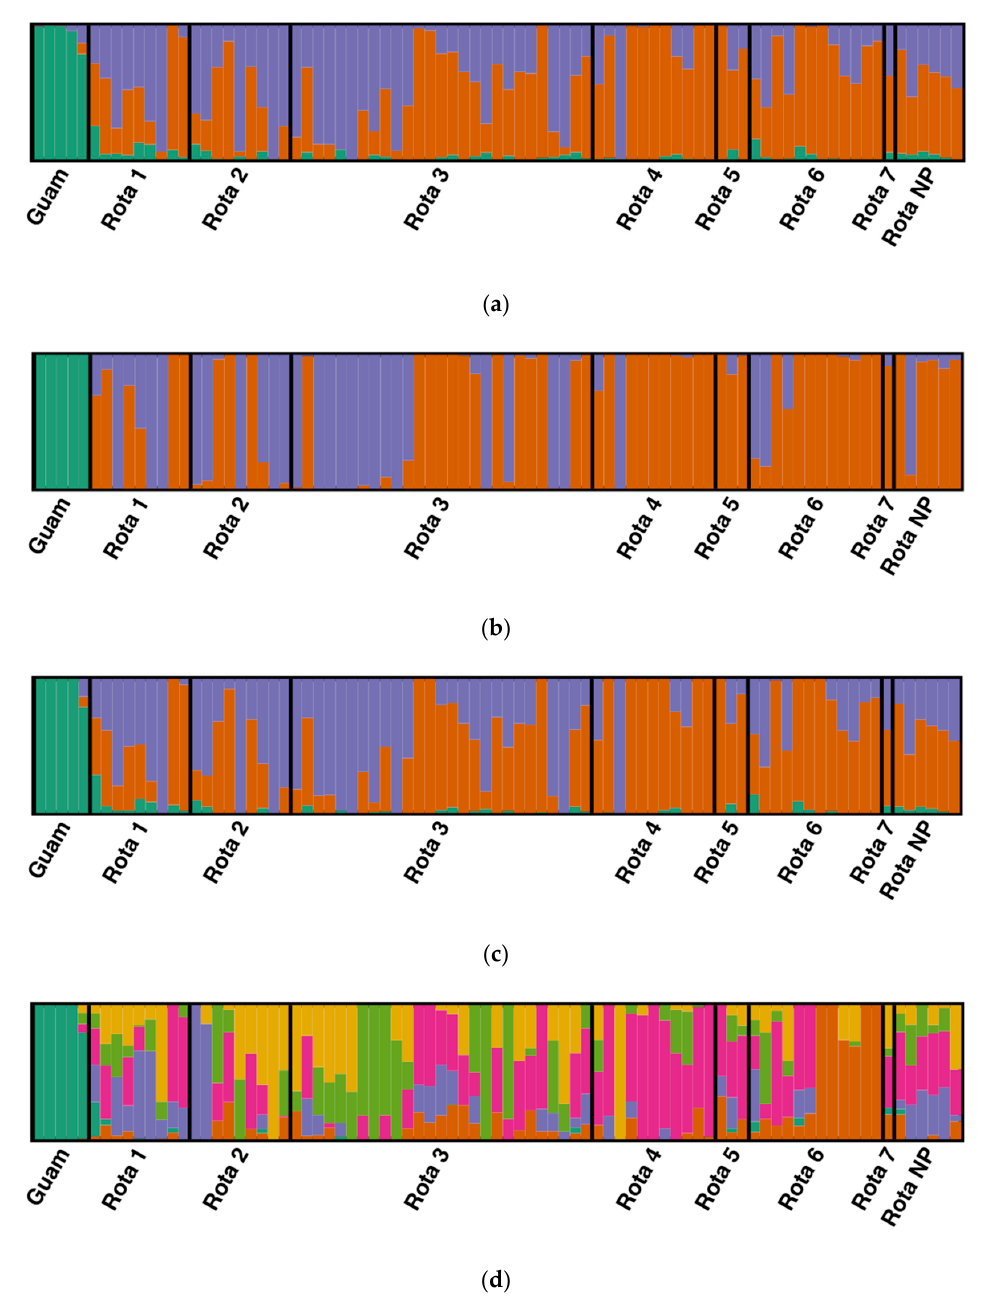
Figure 4. ( a ) Structure analysis showing the mapped Mariana Crow subpopulations of Rota (defined populations 1–7; see Figure 3) and Guam using K = 3. Population “Rota NP” includes Rota individuals of unknown provenance on the island. Each individual is represented by a vertical line partitioned into colored segments representing their proportional assignment to each of the three clusters. Orange and purple correspond to individuals from Rota, while green corresponds to individuals from Guam. ( b ) The Discriminant Analysis of Principal Components (DAPC) shows a very similar pattern to the Structure analysis. Individuals from Guam are differentiated (shown in green). In addition, most of the individuals from Northeast Rota form one group, while the southern portion of the island shows more mixing. ( c ) ADMIXTURE and Structure return nearly identical population assignments for K = 3. ( d ) ADMIXTURE identified some possible additional population structure under the K = 6 model. Figure drawn using D ISTRUCT 1.1 [58].